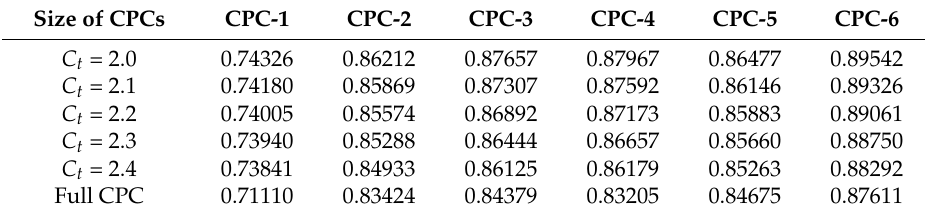
Table 4. Average optical efficiency η of CPCs with θ a = 20 o